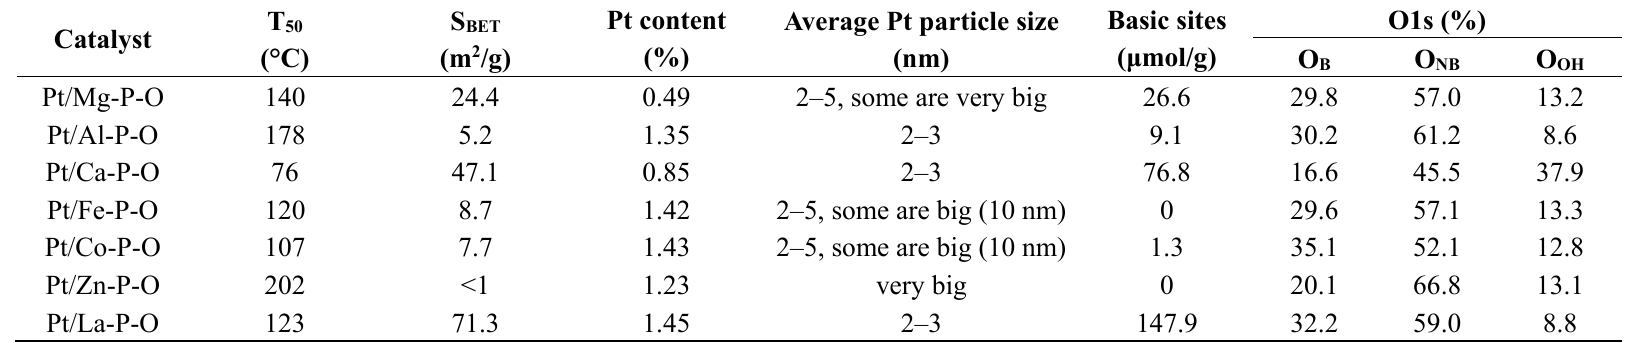
Table 1. T 50 values, specific surface areas, Pt contents, average Pt particle sizes, amounts of basic sites, as well as the distribution of surface oxygen species of Pt/M-P-O catalysts. The T 50 values refer to those of catalysts calcined at 500 °C and pretreated in 4% H 2 at 300 °C. The surface areas and Pt contents refer to those of catalysts calcined at 500 °C. The amounts of basic sites refer to the catalysts calcined at 500 °C and pretreated in 4% H 2 at 300 °C. The average Pt particle sizes and the distribution of surface oxygen species (O B : bridging